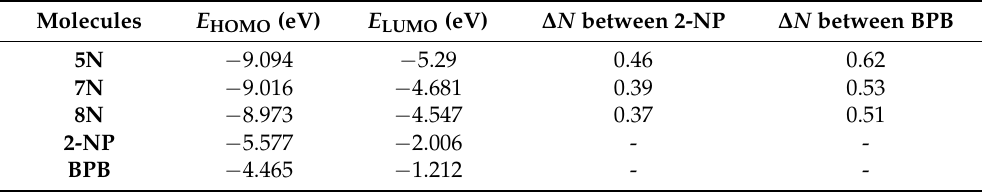
Figure 8. The FMOs of surfactants, 2-NP and BPB, as well as the optimized adsorption configuration of surfactants to 2-NP and BPB. Table 6. Frontier orbitals’ calculation parameters of surfactants and